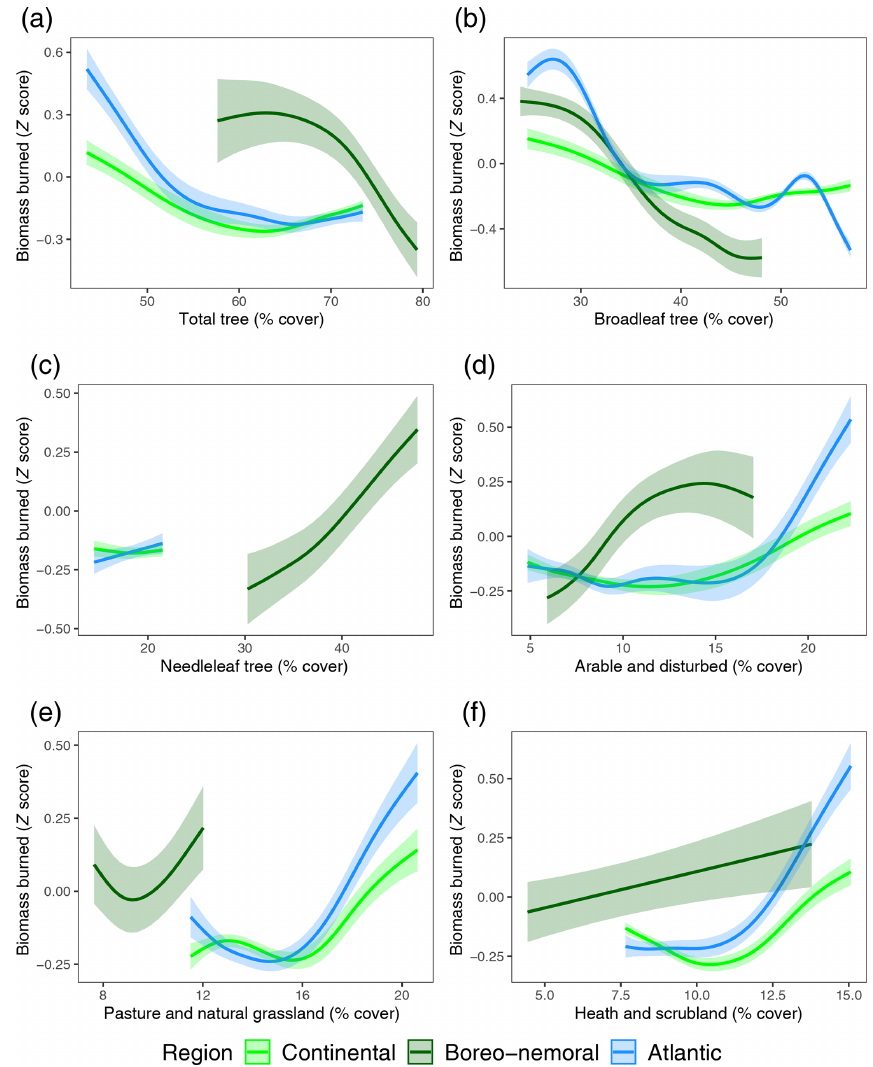
Figure 4. Fire fuel type and load relationships in central and eastern Europe. The relationship between biomass burning, determined from Z -score composite charcoal values, and the main land cover types, derived from percentages of pollen-based land cover classes. These relationships were developed from generalized additive models (GAMs) for each ecoregion. Total tree cover (a) , broadleaf tree cover (b) , needleleaf tree cover (c) , arable and disturbed cover (d) , pastures and natural grasslands cover (e) , and heath and scrubland cover (f) .